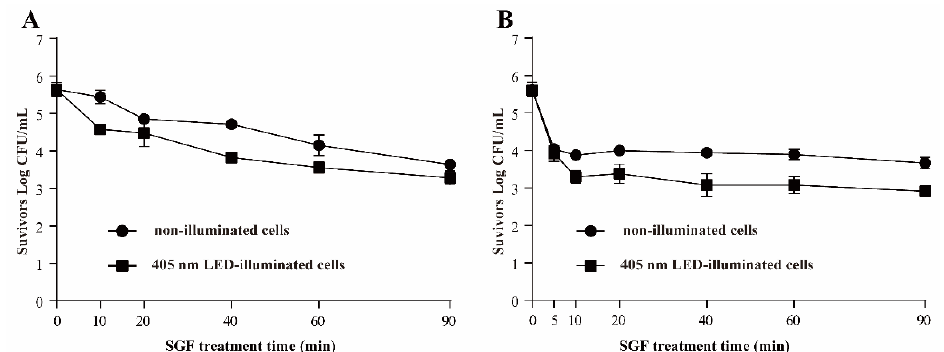
Figure 6. Survival of S . Typhimurium in simulated gastric fluid (SGF) at pH 3 ( A ) and pH 2 ( B ). ( ● ) non-illuminated cells, ( ■ ) 405 nm LED-illuminated cells.